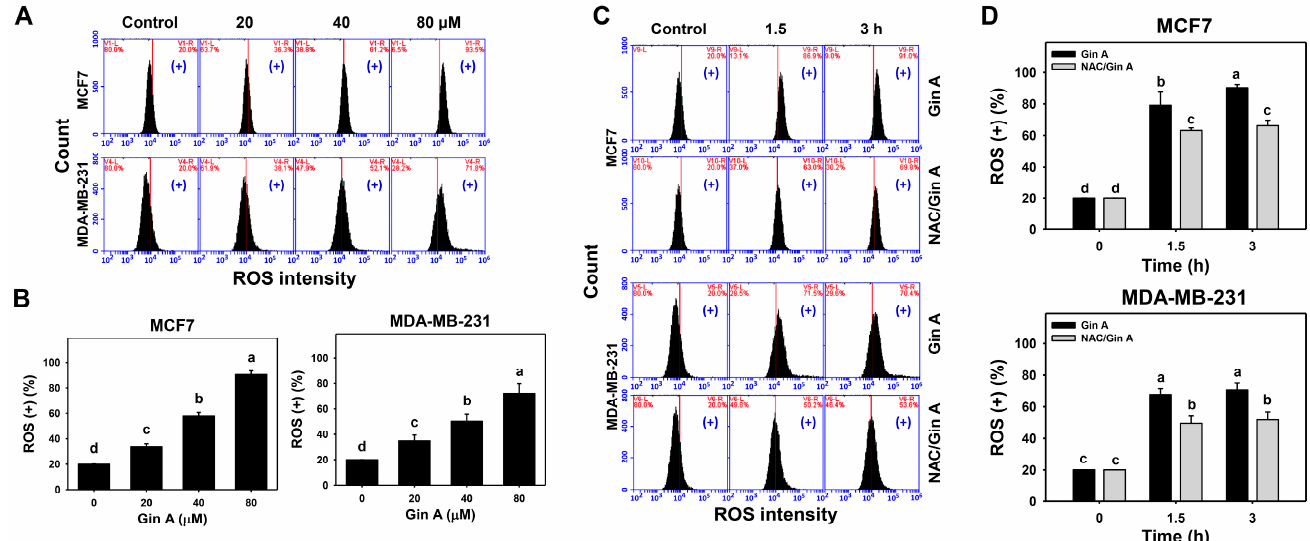
Figure 3. Impact of Gin A on ROS level of breast cancer cells. ( A , B ) ROS level. Cells were treated with 0 (0.1% DMSO; control), 20, 40, and 80 µ M Gin A for 3 h. Subsequently, they were subjected to ROS flow cytometry. (+) indicates ROS (+) populations. ( C , D ) NAC reverted effects on ROS level. Cells were pretreated with NAC (10 mM) for 1 h and then post-treated with Gin A (control and 80 μ M) for 0, 1.5, and 3 h, namely NAC/Gin A. Data, means ± SDs ( n = 3). When the connecting letters are overlapping, it means their difference was significant for multiple comparisons ( p < 0.05 to 0.0001). For the example of MCF7 cells ( D ), Gin A at 0, 1.5, and 3 h showing d , b , and a differs significantly. NAC/Gin A at 1.5 and 3 h showing c differs non-significantly.